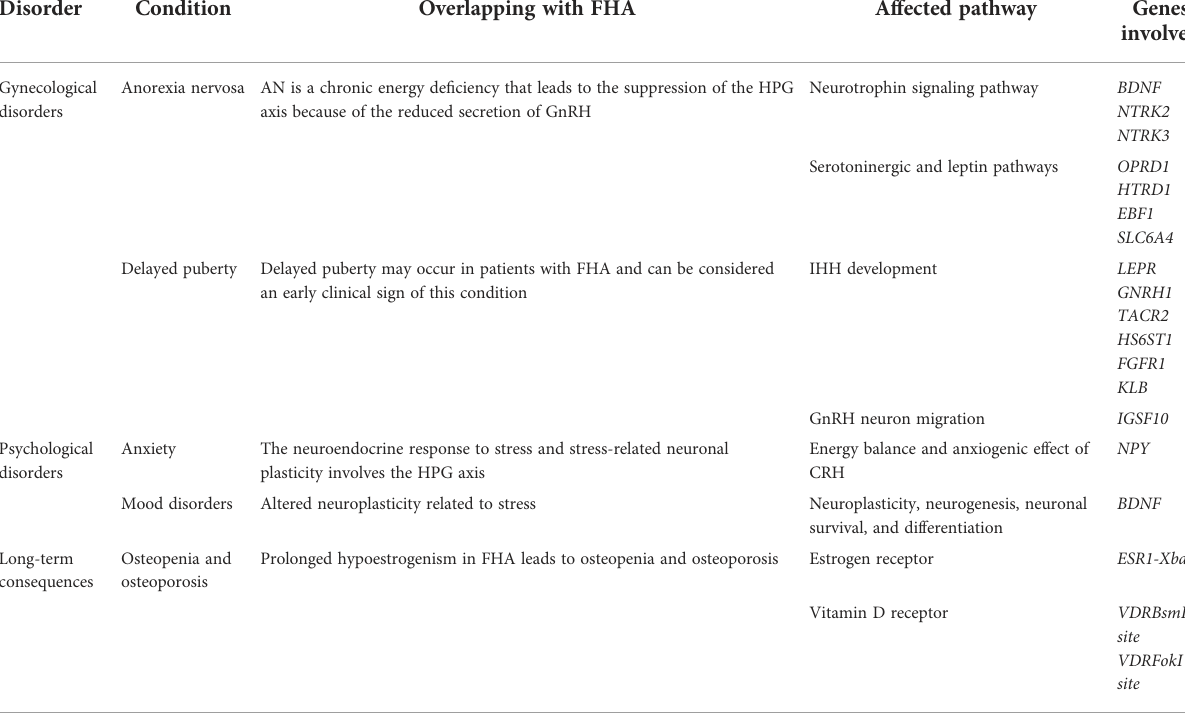
TABLE 2 Predisposing genes to gynecological and psychological conditions showing overlapping features with FHA, and to long-term consequences of FHA.